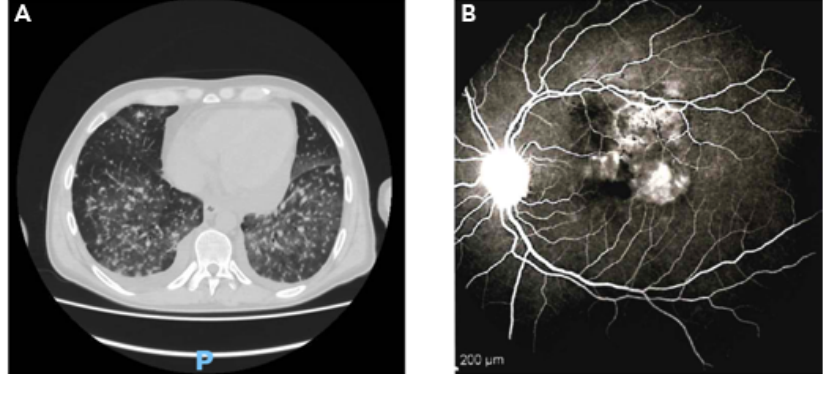
Figure 1. Evidence of mycotic localization in lungs (A) and eye (B), as described in